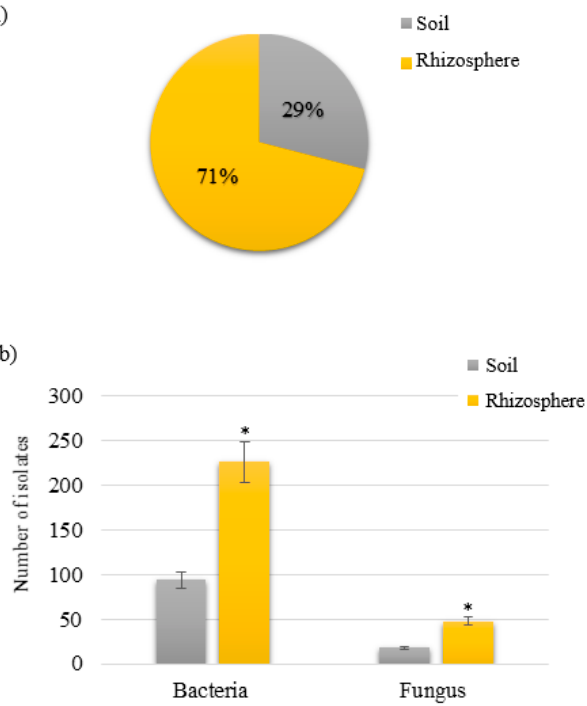
Figure 2. Spore-forming microbes (SFM) distribution according to the sample type. ( a ) Total percentage of SFM. ( b ) Total Number SFM based on sample type. * means a value with p ≤ 0.05 was considered an indication of statistical significance.